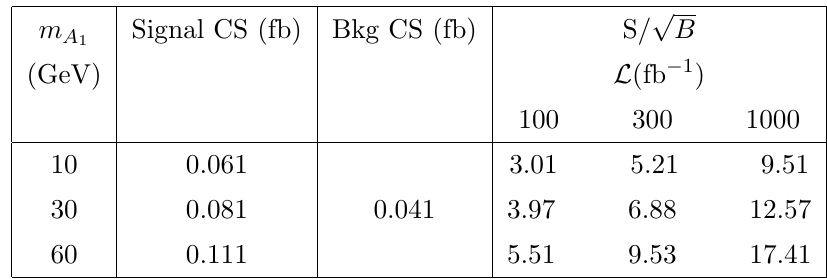
Table 6 . Signal signi(cid:12)cance for three values of m A